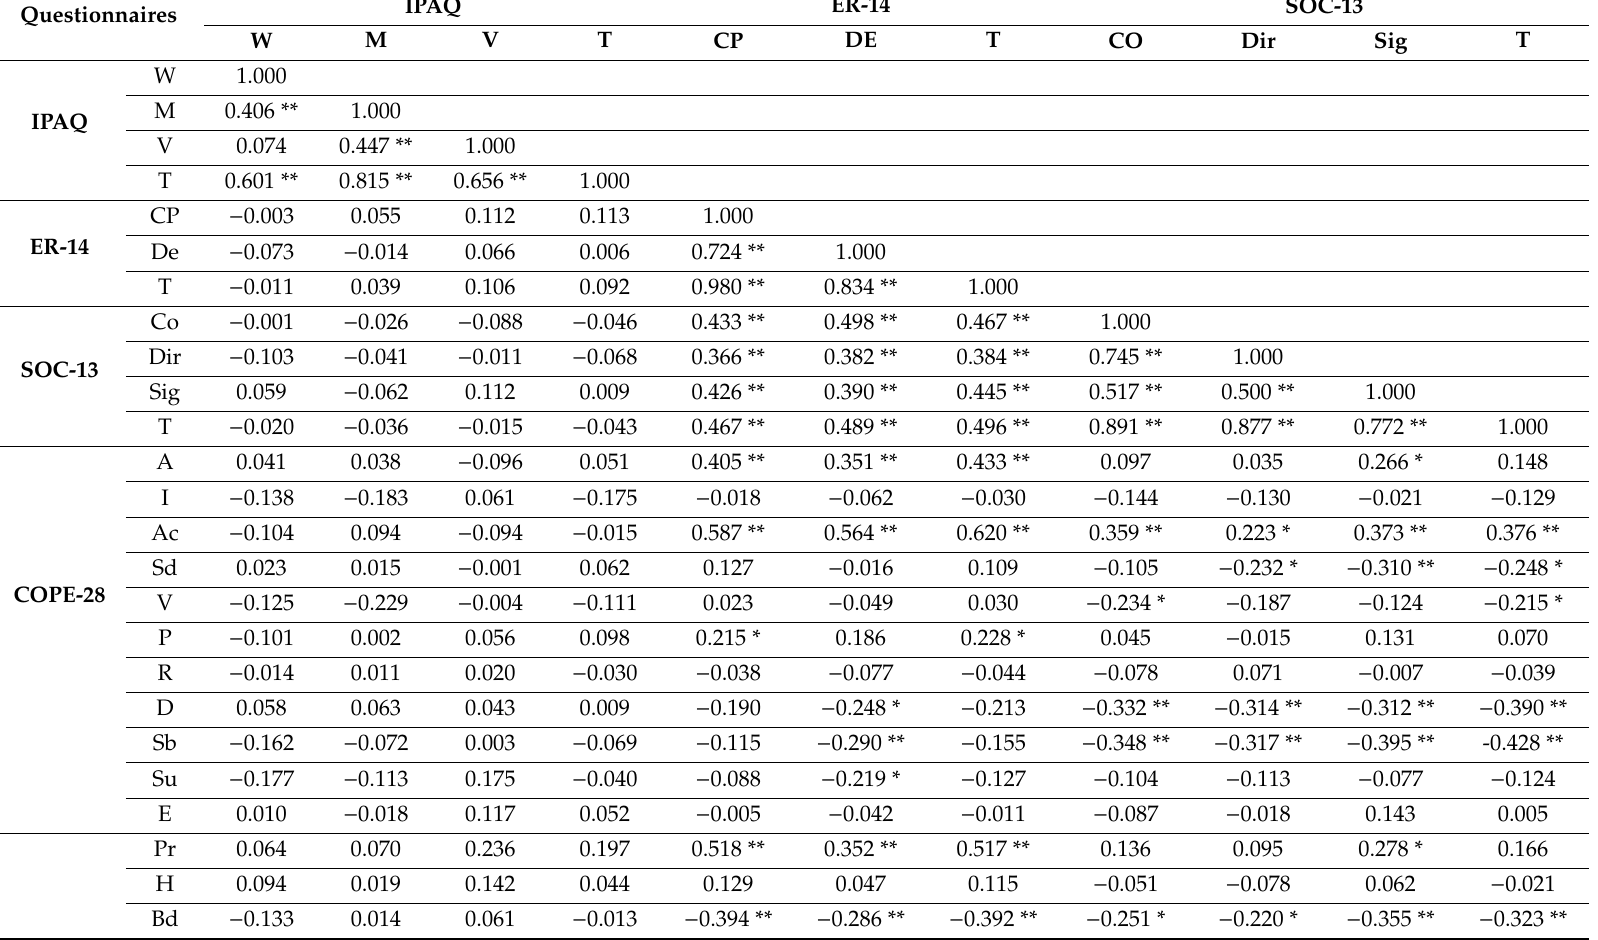
Table 5. Spearman’s rho correlations of physical activity, resilience, sense of coherence and